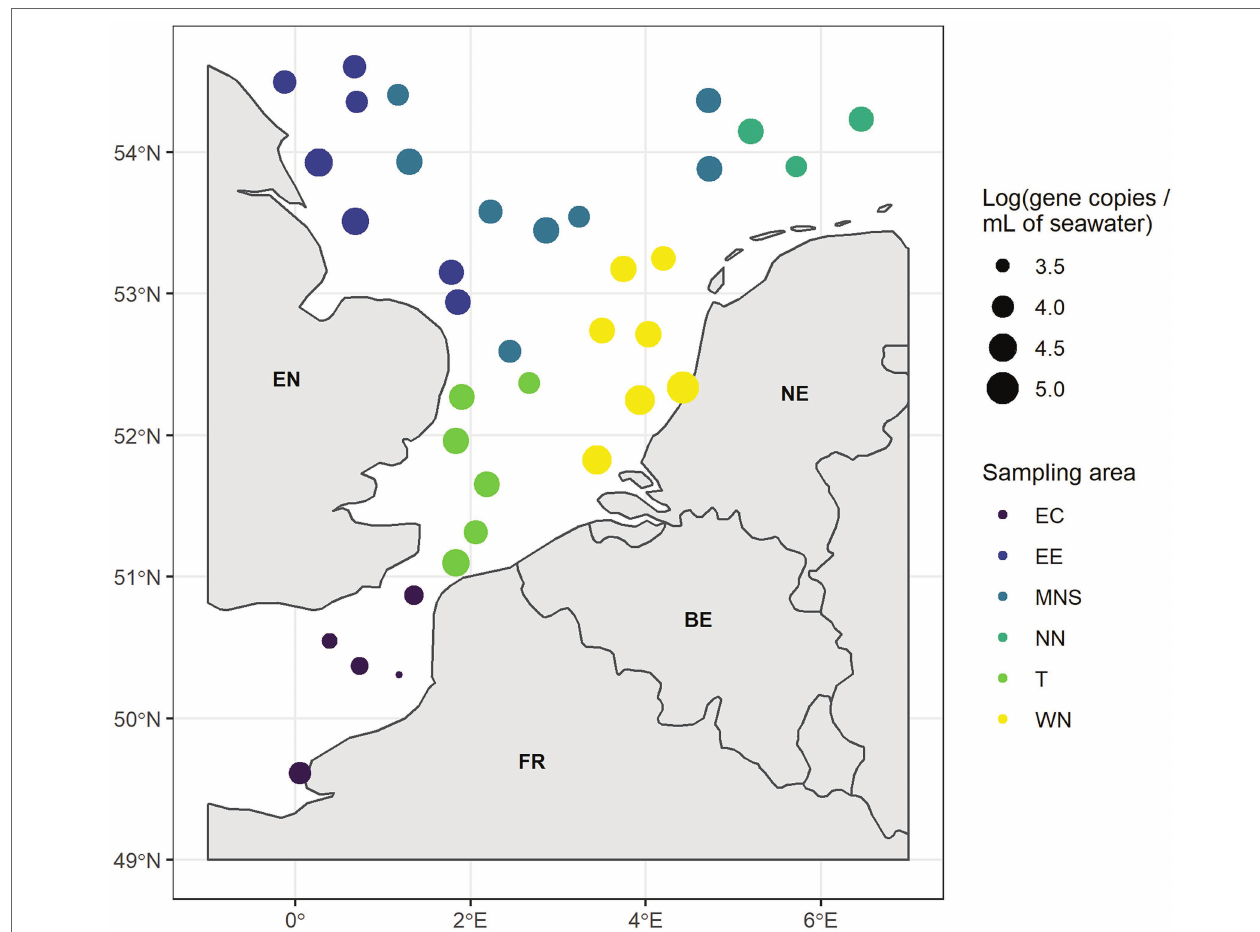
FIGURE 3 | Absolute abundance of the tuf gene (gene copies.ml -1 of seawater, log-transformed) in the six areas. EC, East English Channel; EE, East England coast; MNS, Middle of the North Sea; NN, North Netherlands coast; T, Thames mouth; and WN, West Netherlands coast. EN, England; NE, Netherlands; FR, France; and BE,